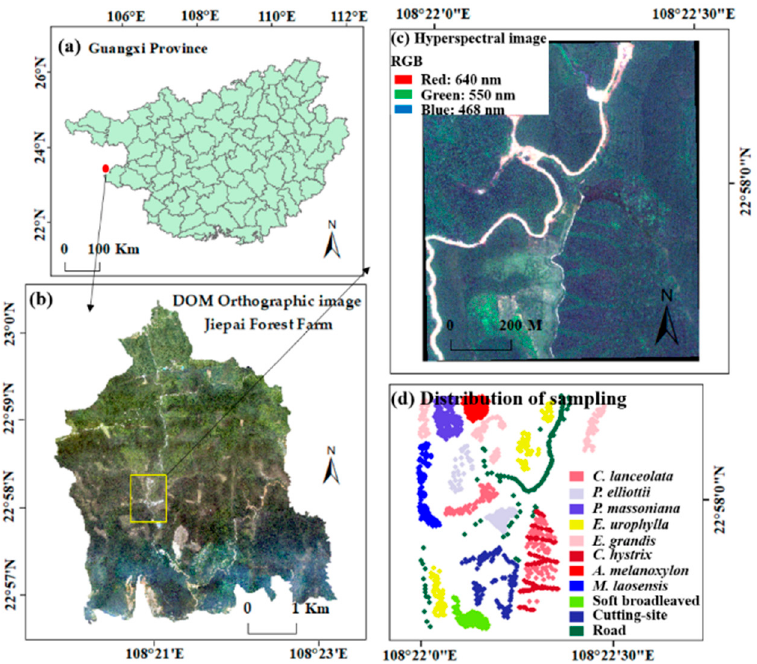
Figure 1. Location of the study area. ( a ) vector map of Guangxi Prefecture-level city; ( b ) digital orthophoto map (DOM) of Jiepai Forest Farm; ( c ) hyperspectral images of the study area (false color composite (FCC); R, band 53; G, band 34; B, band 16); ( d ) distribution of sample points.